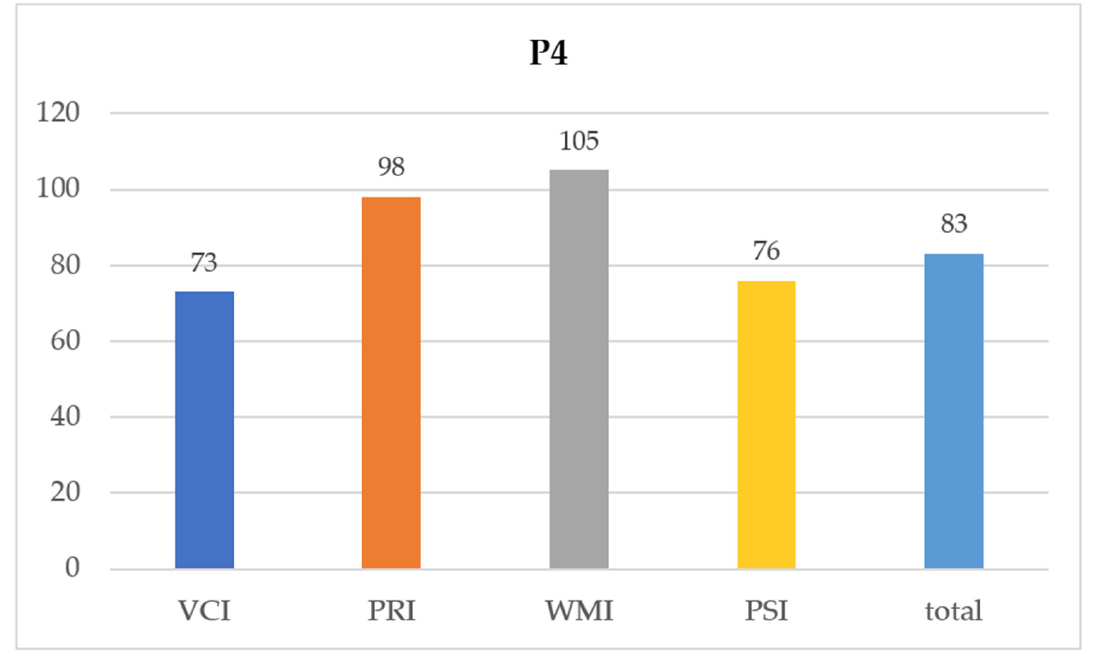
Figure 2. Patient 4 pro fi le—IQ total and indices (WISC-IV).